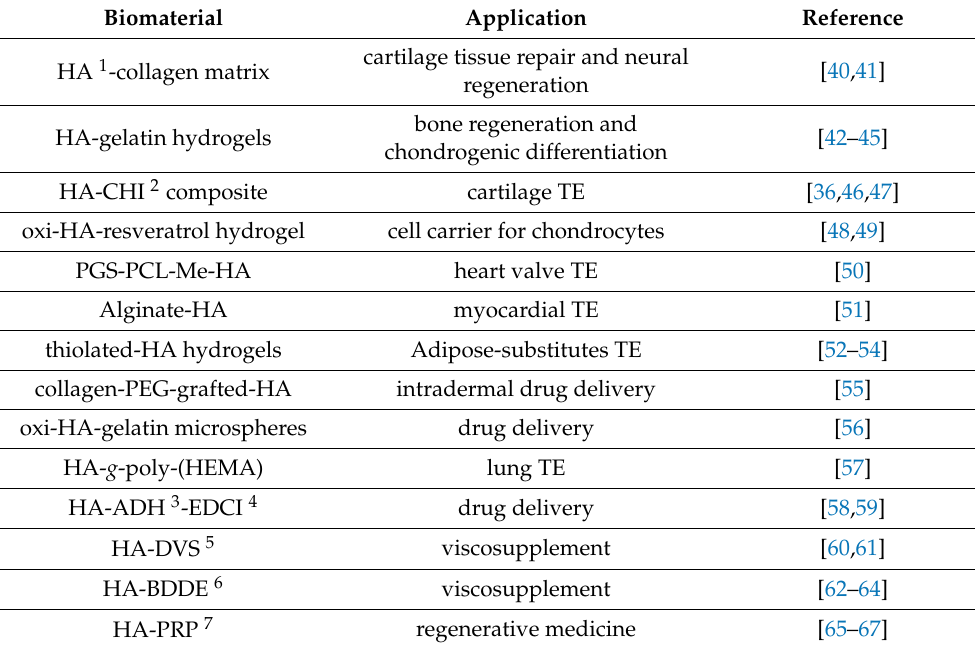
Table 1. Applications of HA-cross-linked hydrogels in the biomedical field.